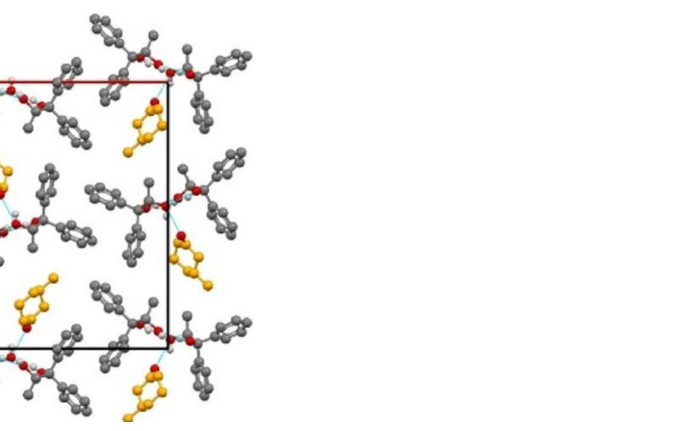
Figure 31. KUCJAT. The carbons of 3-methylcyclohexane are marked in orange and H CH have been removed for the sake of clarity